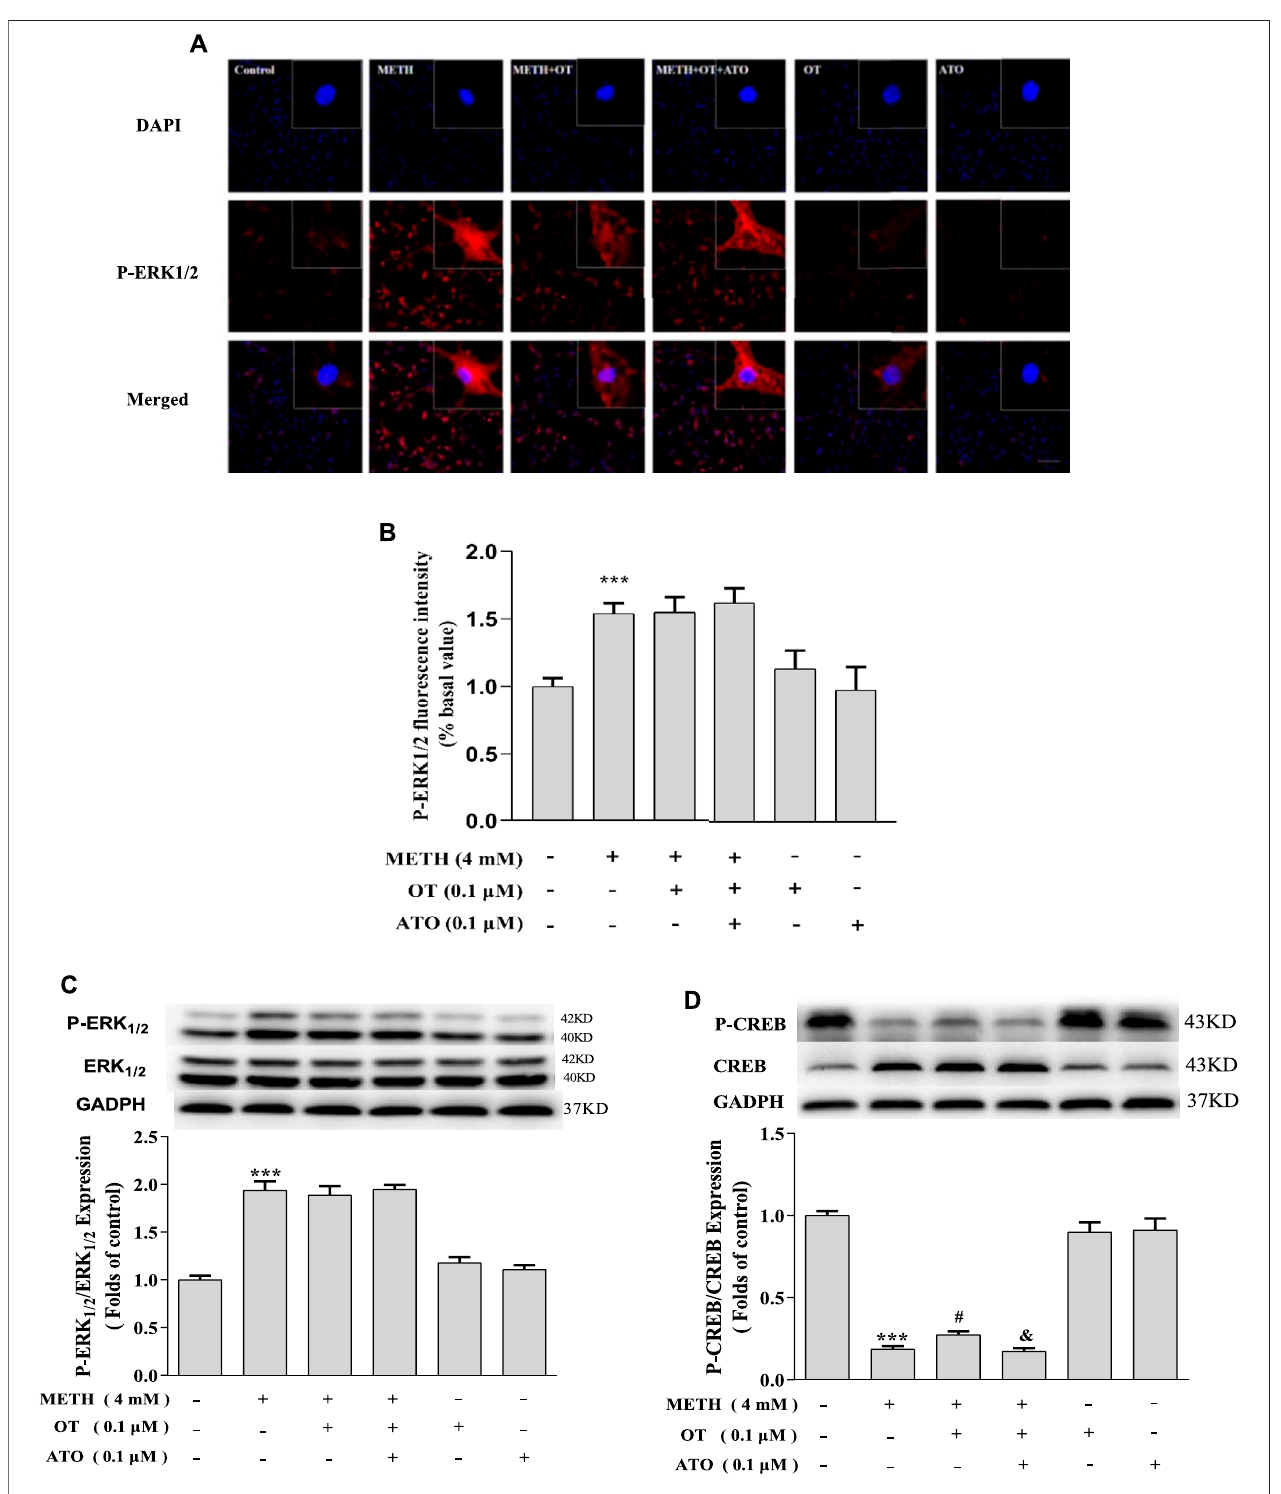
FIGURE6| EffectsofOTandATOontheexpressionofP-ERK1/2andP-CREBchangedbyMETHinthehippocampalneurons. (A – D) Hippocampalneuronswere pre-treated withOT (0.1 μ M) and ATO(0.1 μ M) for2 h and stimulated with METH (4 mM)for24 hby fl uorescence dyeing and western blotting.Thedata wereshown as mean ± SEM ( n (cid:2) 3). *** p < 0.001 compared with control groups; # p < 0.05 compared with METH groups; & p < 0.05 compared with METH + OT groups.